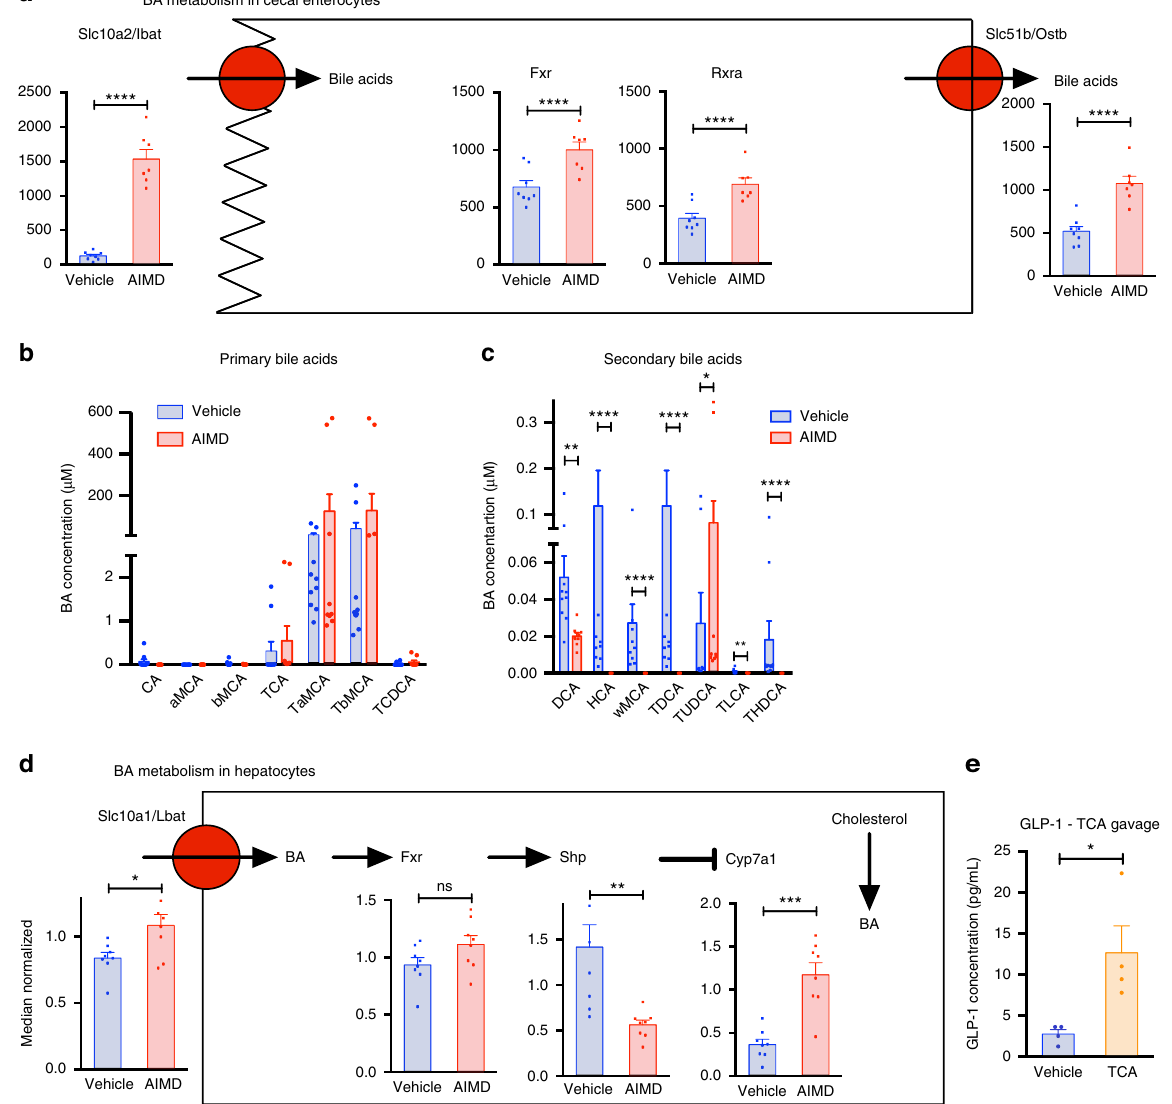
Fig. 7 AIMD alters BA metabolism which can potentiate GLP-1 response. a Quanti fi cation by RNA-sequencing of Slc10a2, Fxr, Rxra, and Slc51b mRNA expression in the cecum ( n = 7 – 8/group). Adjusted p value from negative binomial Wald test (corrected for multiple hypothesis testing with